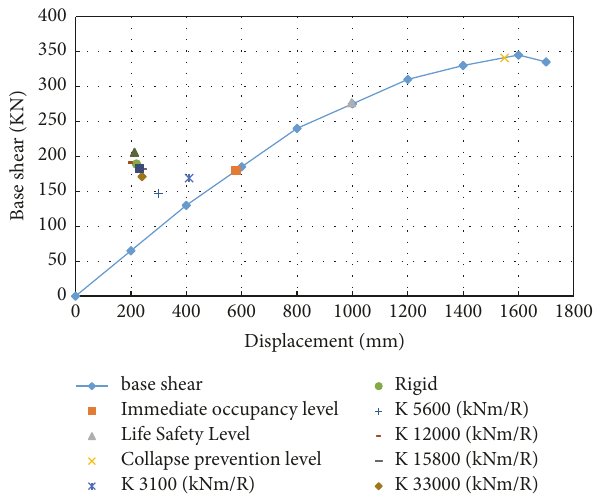
Figure 13: Base shear versus displacement at the top (15-storey